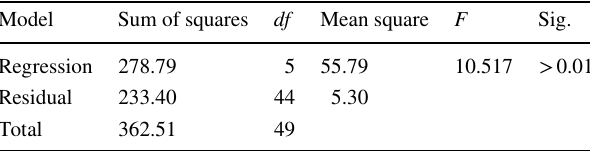
Table 2 The results obtained through the linear model with multivari- ate regression method (karst spring)